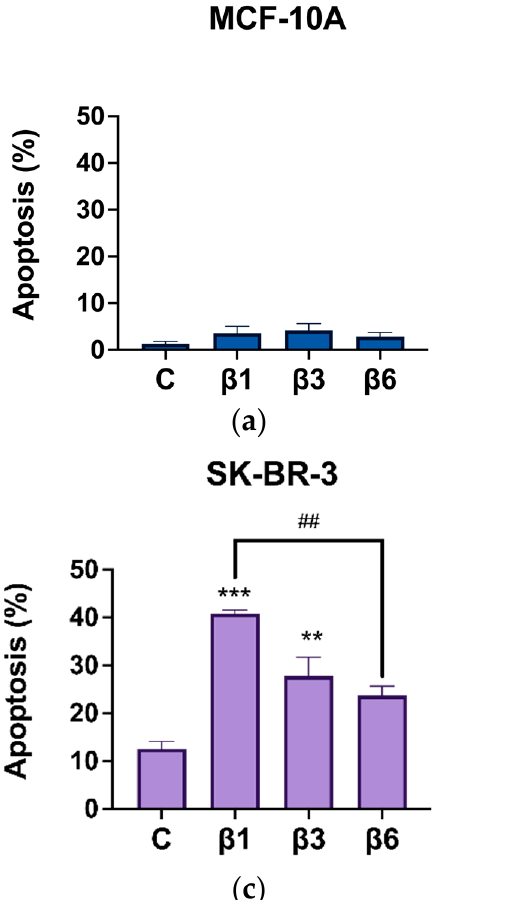
after the treatment of cells with these proteins (Figure 4). Representative dot plots for apoptosis and ferroptosis detection by flow cytometry are shown in Figures S3 and S4 of the Supplementary data,